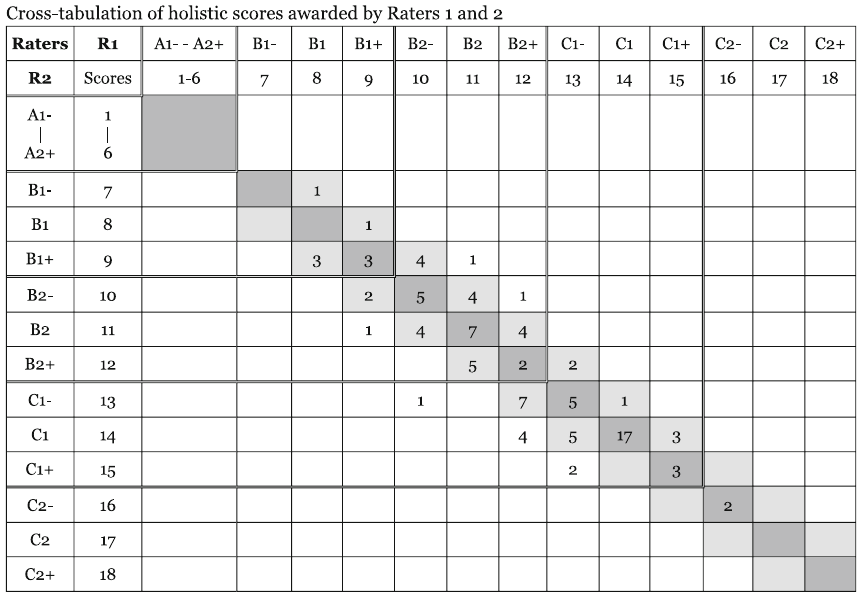
Rating results of ten samples by six teachers of English Table 9 lists ten samples that were sent to the six teachers of English for independent rating. R1 and R2 awarded the same CEFR levels, except for item 3 (Extract code 003) with a slight difference of one sub-band. Teachers (T) 1 and 2 who were trained to- gether with R1 and R2 performed equally well; each had six samples at the same level as R1 and R2 and the remaining four at an adjacent level. T3, T4, and T6 without any training in scoring on the CEFR scales diverged more from R1 and R2 with five, seven, and five samples respectively at an adjacent level. Among the jagged scores, the cells shaded in light gray are lower by one level, while those in dark gray are higher. Among these six teachers of English, T5 ’ s rating performance is the more accurate. All the four jagged cases marked by T1 are lower than R1 and R2. In contrast, T4 tended to give higher marks. Interestingly, in contrast to the tendency reported by Koster and Koet